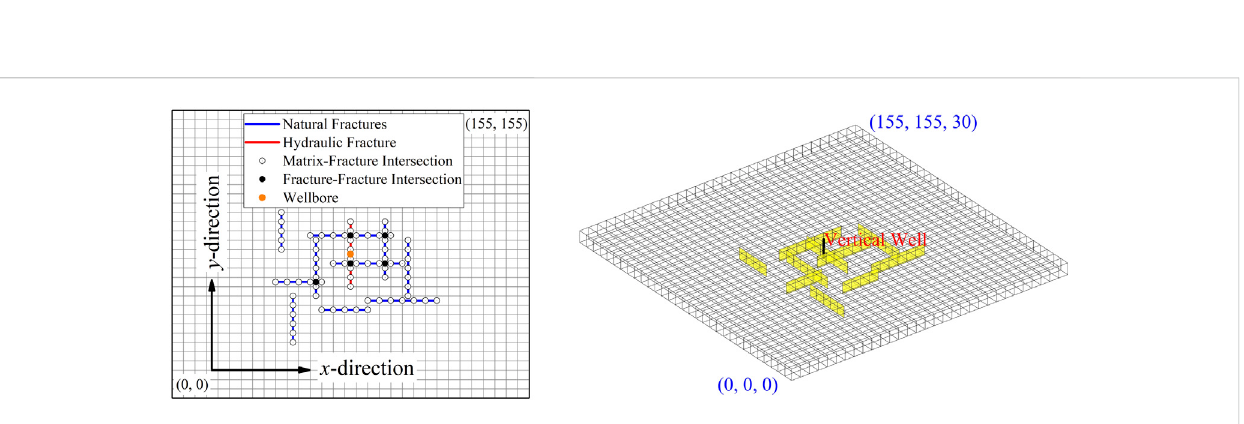
Schematic diagram of complex fracture network model used for